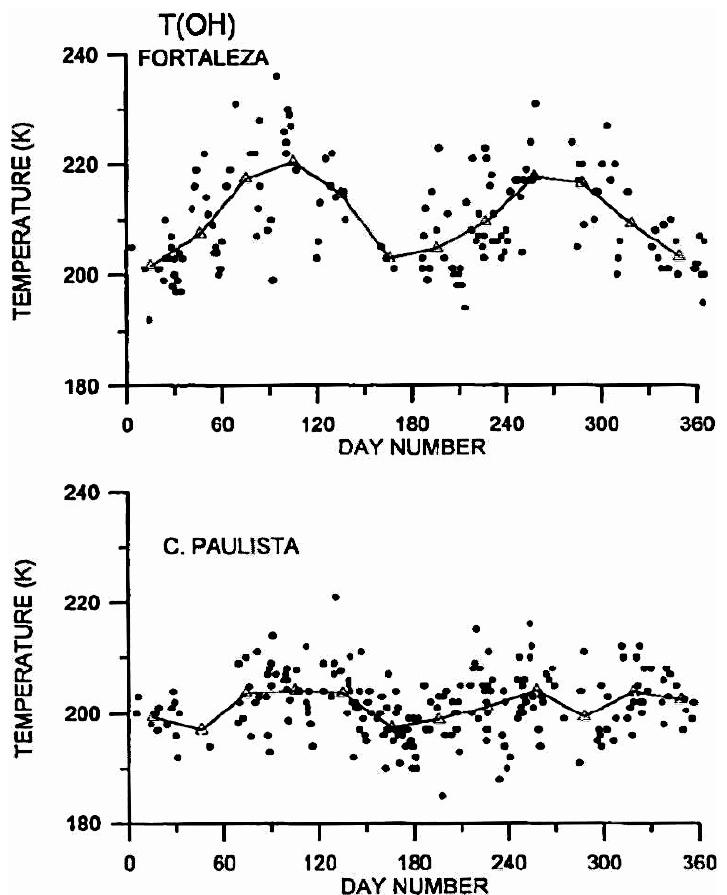
Fig. 3. Seasonal variations in OH rotational temperature for two low-latitude locations (after Takahashi et al.,